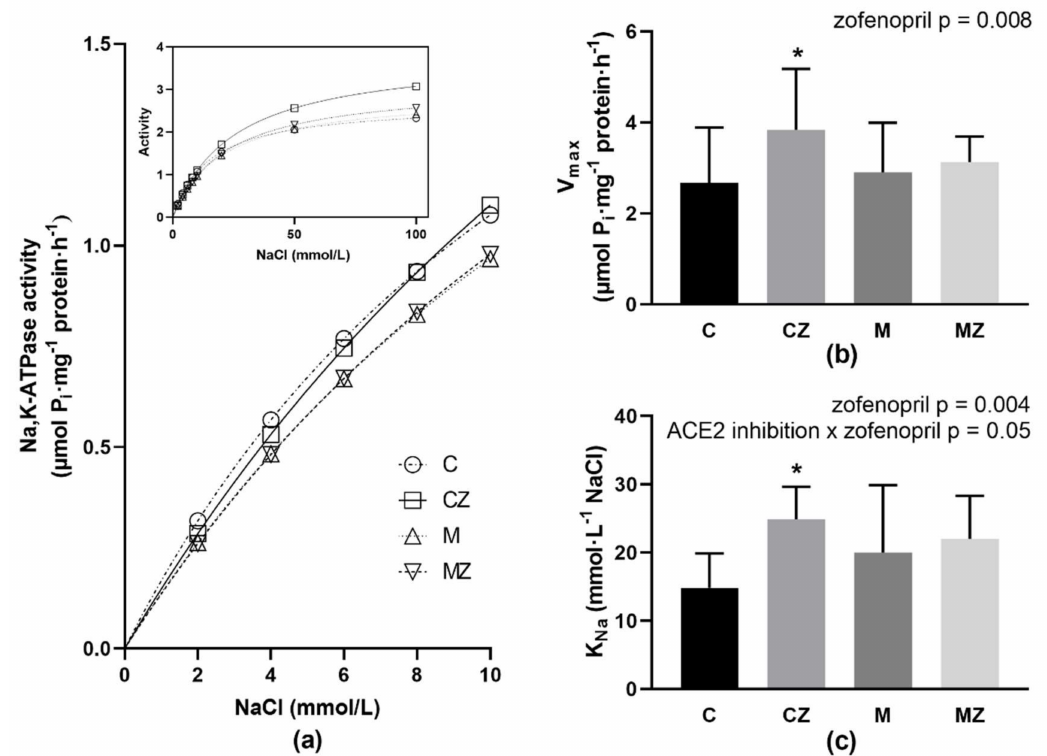
Figure 5. Activation of the Na,K-ATPase in Na + concentrations ranging from 2 to 10 mmol/L; insert—activation of the enzyme in the whole investigated concentration range of NaCl ( a ), kinetic parameters of Na,K-ATPase V max ( b ) and K Na ( c ) in erythrocyte membranes. Abbreviations: C—control group, CZ—zofenopril-treated group, M—MLN-treated (MLN- 4760, ACE2 inhibitor) group, MZ—zofenopril and MLN-treated group. V max —maximal velocity of reaction. K Na —NaCl concentration required for 1 maximal activation of Na,K-ATPase, * p < 0.05 versus control group. Data are presented as 2 means ± standard